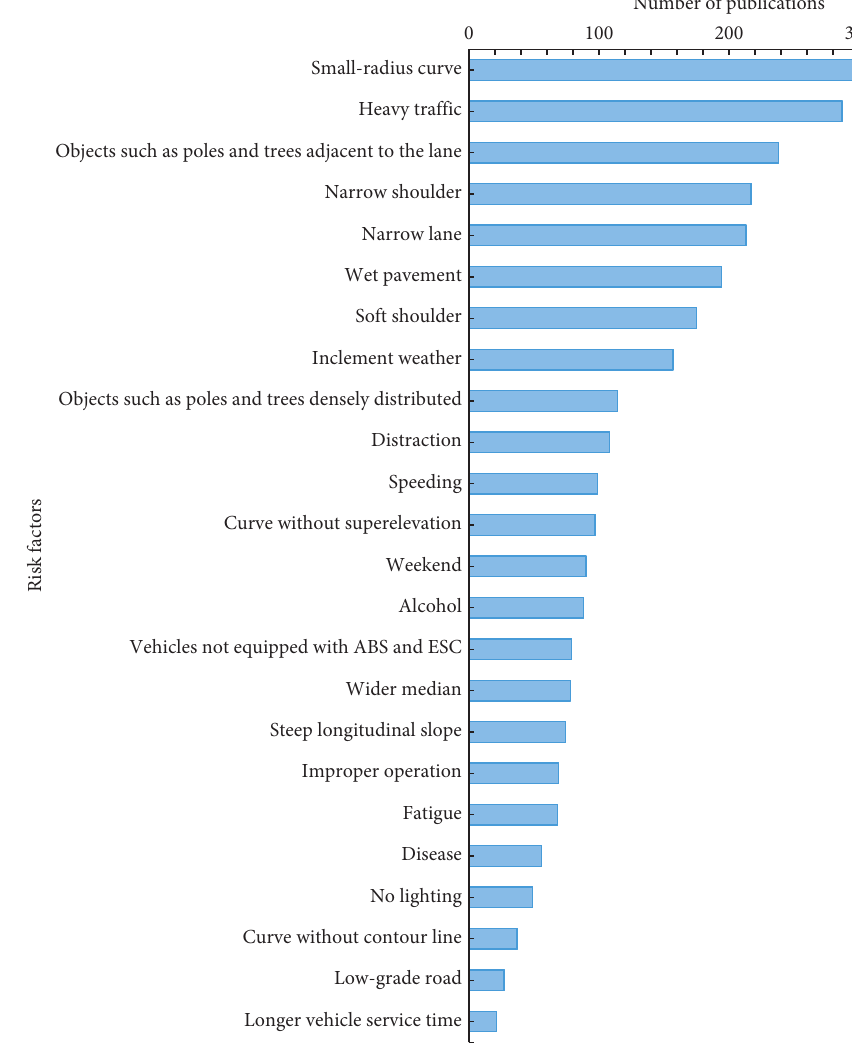
Figure 4: Risk factors of roadside